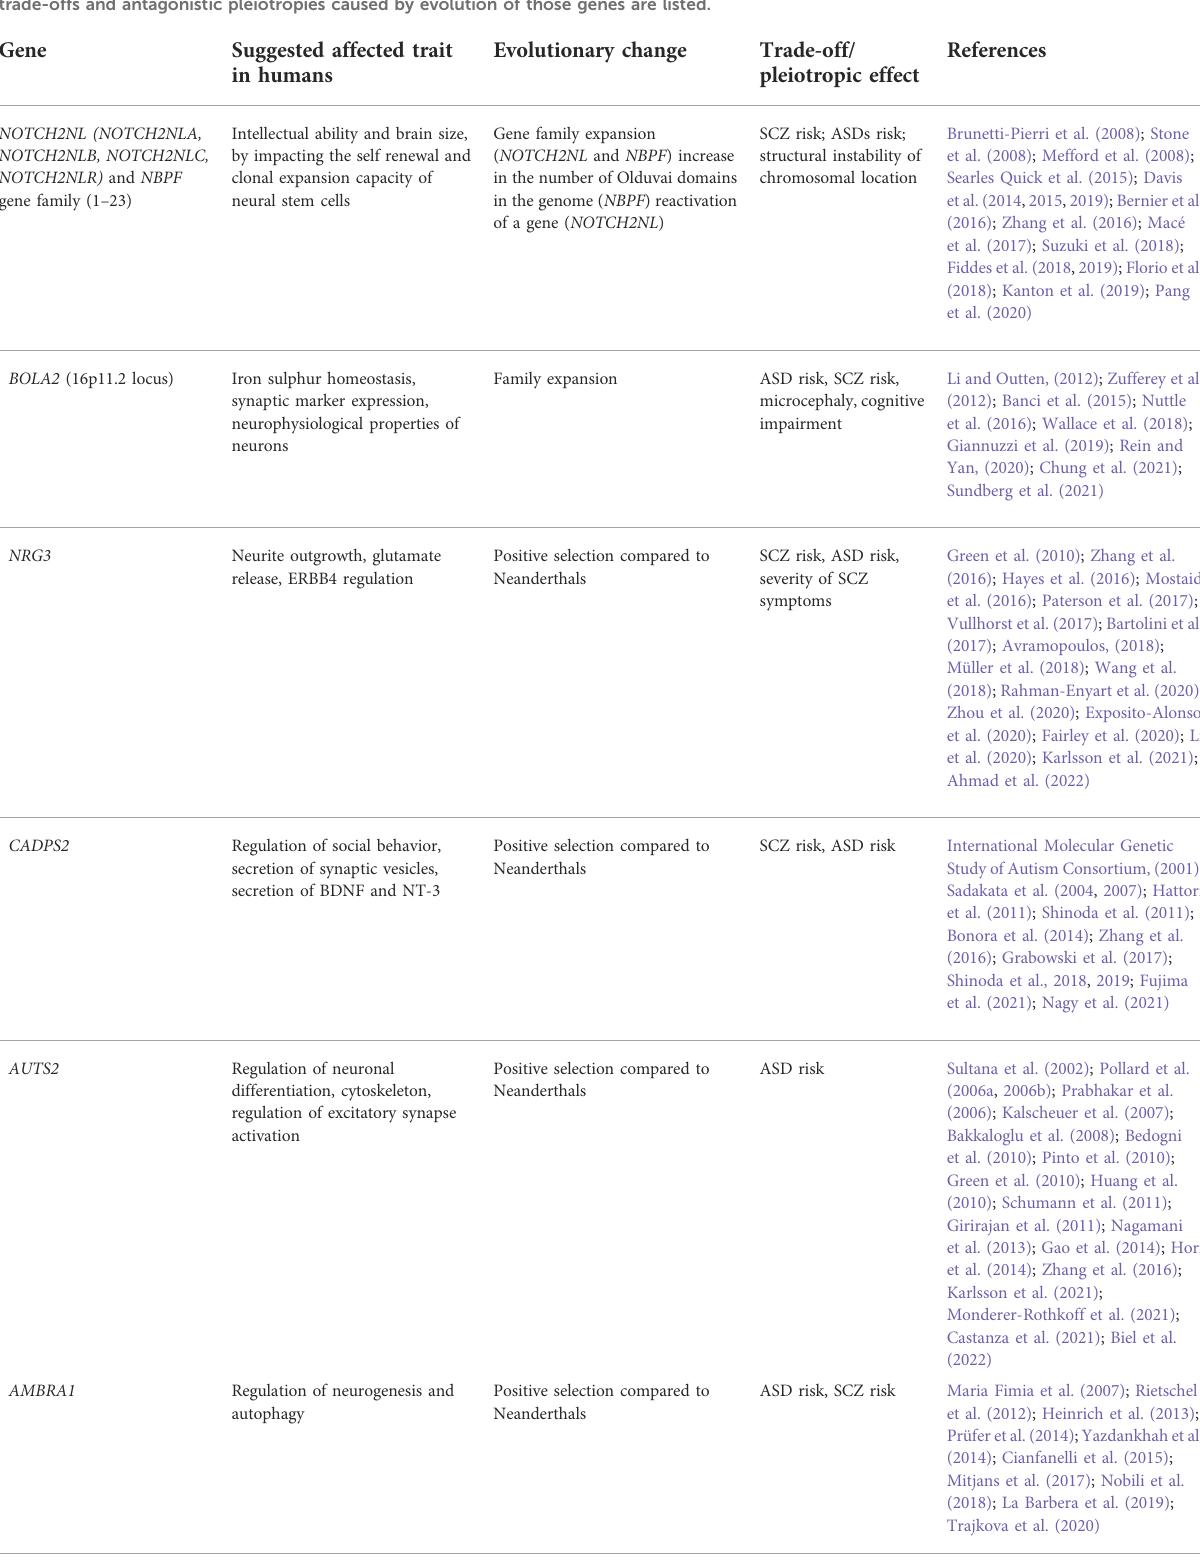
TABLE 1 Summary of genes which are implicated in ASD and SCZ, and bear signs of recent evolution in humans. Observed or proposed evolutionary trade-offs and antagonistic pleiotropies caused by evolution of those genes are